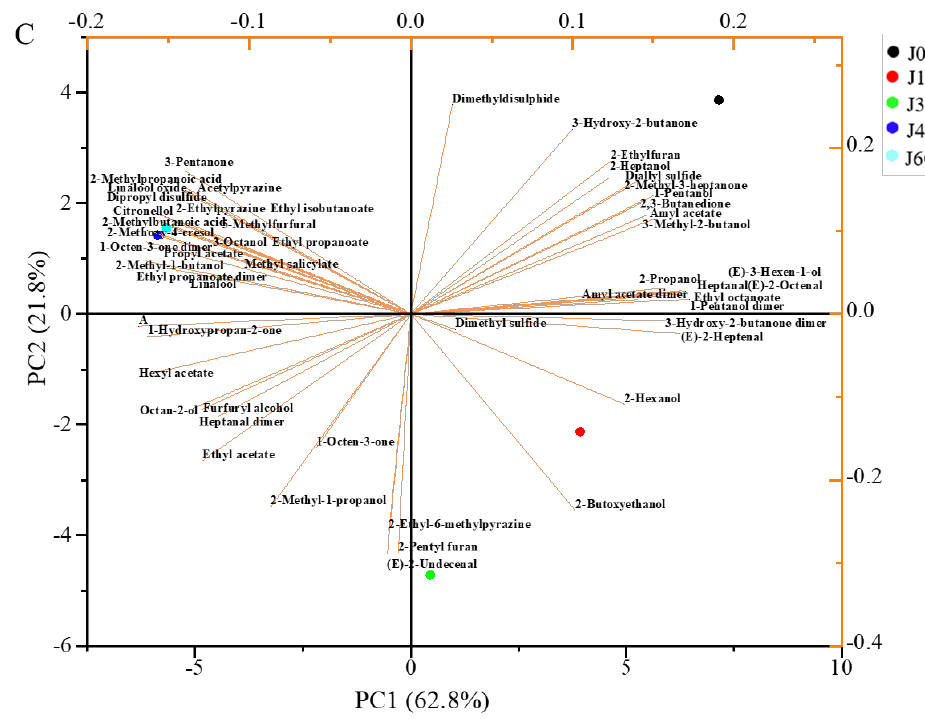
Figure 7. PCA analysis of Jinsixiaozao. ( A ) Score plot of the first two principal components, J0, J15, J30, J45, and J60 represent refrigeration for 0, 15, 30, 45, and 60 days, respectively. ( B ) Loading plot of different variances, ( C ) biplot of PCA.